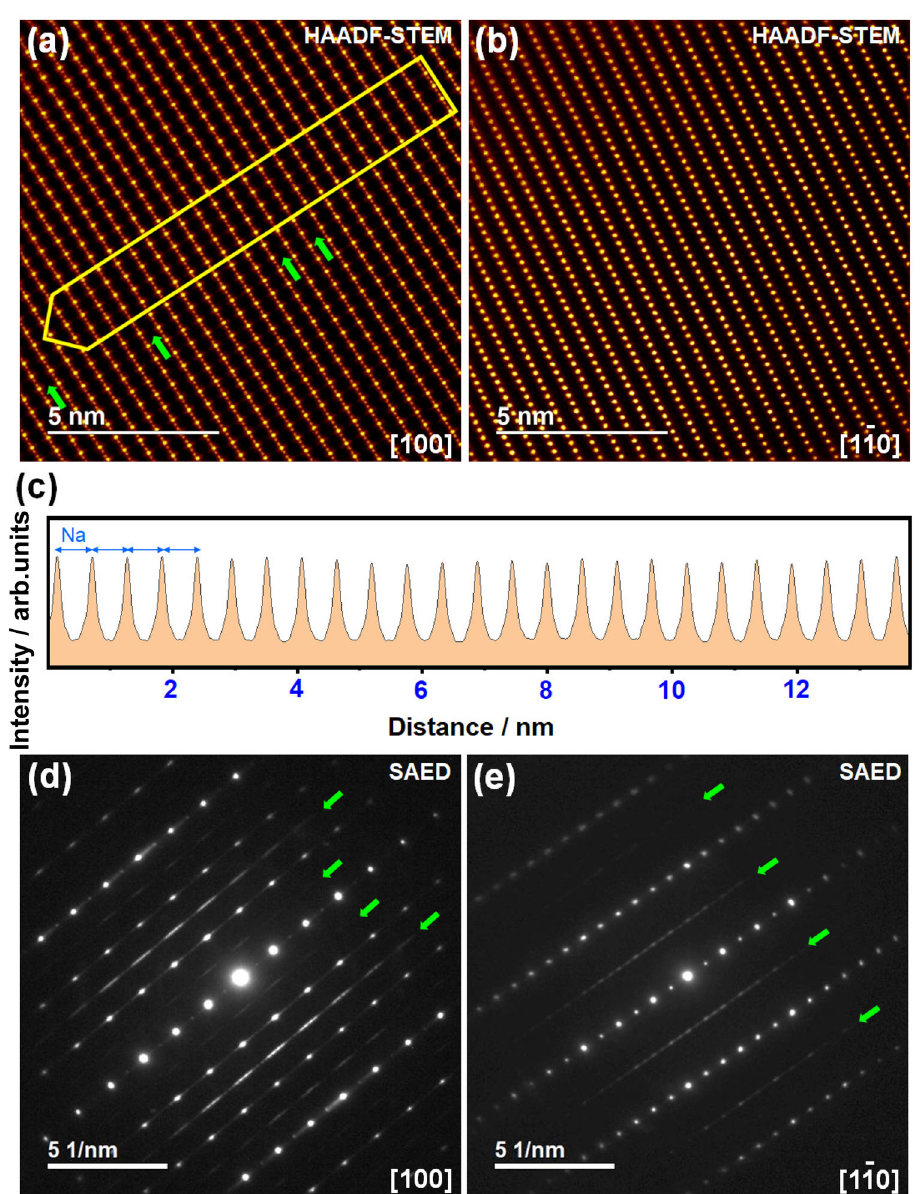
Fig. 7 Structural changes during cycling of NaKNi 2 TeO 6 in NaK batteries. HAADF-STEM ex situ images of NaKNi 2 TeO 6 upon complete discharging for three cycles in NaK cells taken along ( a ) [100] axis and ( b ) [1 (cid:1) 10] zone axis. Green arrows show Na atom layers where the adjacent Te/Ni slabs shift. A rationale for the slab shear transformations has been provided as Supplementary Note 1. c Intensity line pro fi les as highlighted in ( a ) showing equidistant interlayer spacings (0.55 nm) along the [001] axis revealing NaKNi 2 TeO 6 to preferentially insert Na atoms into the lattice. SAED patterns taken along ( d ) [100] axis and ( e ) [1 (cid:1) 10] axis showing streaks (underpinned in green arrows) indicative of the modulation in the Na arrangement as is exempli fi ed in Na 2 Ni 2 TeO 6 37